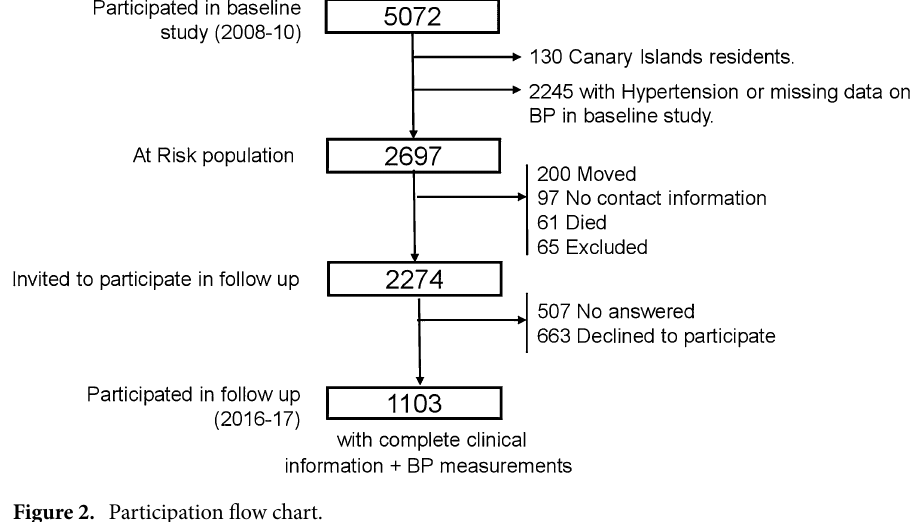
Figure 2. Participation flow